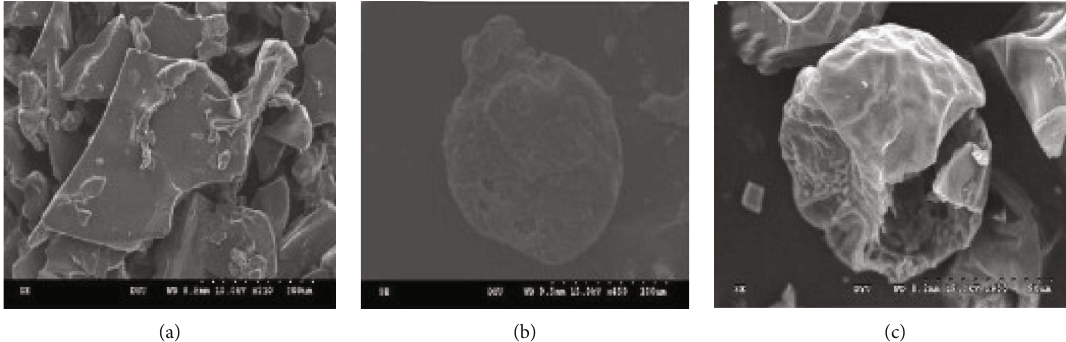
Figure 41: SEM micrographs of γ -Na + -PGA (a) raw material (210 × magni fi cation), γ -Na + -PGA microencapsulation, (b) (450 × magni fi cation), and (c) (900 × magni fi cation) [118].